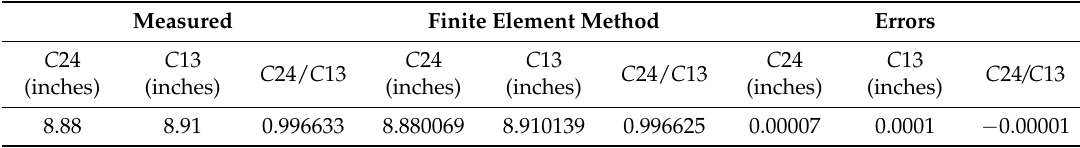
Table 5. Calculated deformation from the estimated parameters using FEM. Measured Finite Element